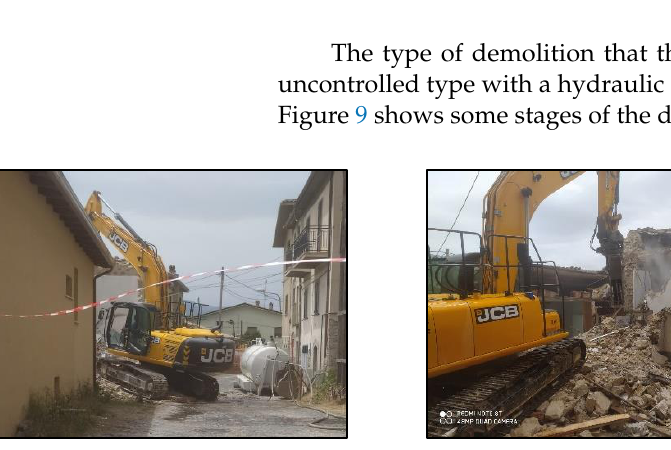
Figure 9. Three different stages of demolition.